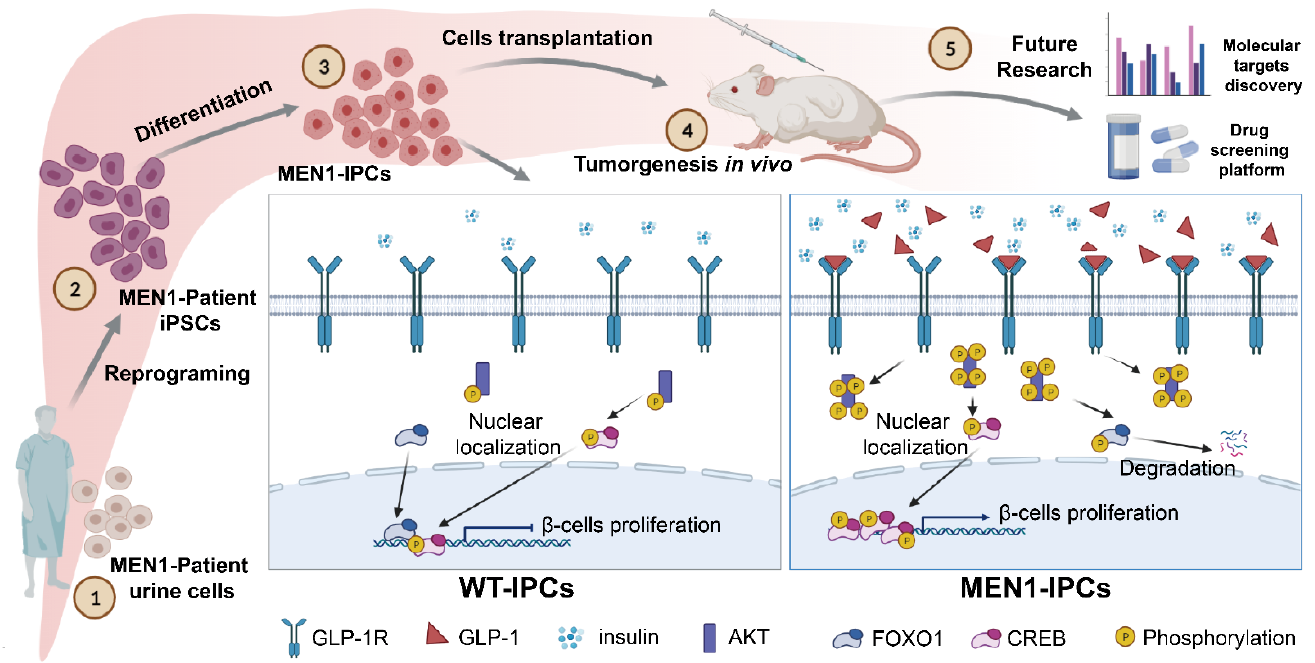
Figure 7. The illustration of MEN1 disease modeling with patient-origin iPSCs revealed GLP-1R- mediated hyperproliferation of β -cells and hypersecretion of insulin.